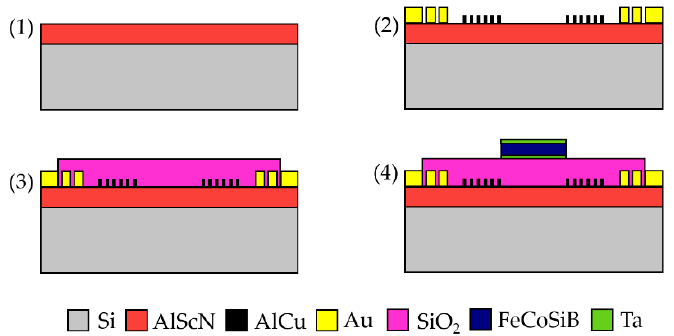
Figure 2. Schematic cross-sections of the processing steps of the thin film SAW sensor. (1) A layer of 1 µm AlScN is sputter-deposited on top of a high-resistance silicon (001) wafer, followed by 200 nm AlCu IDTs and 300 nm gold contacts with a 40 nm WTi adhesion layer that are patterned afterwards (2). A 1.5 µm SiO 2 layer is deposited via PECVD and thinned with CMP to a thickness of 1 µm (3). On top, the magnetostrictive FeCoSiB film with a thickness of 200 nm is deposited with an additional layer of 10 nm Ta on the top and on the bottom (4).